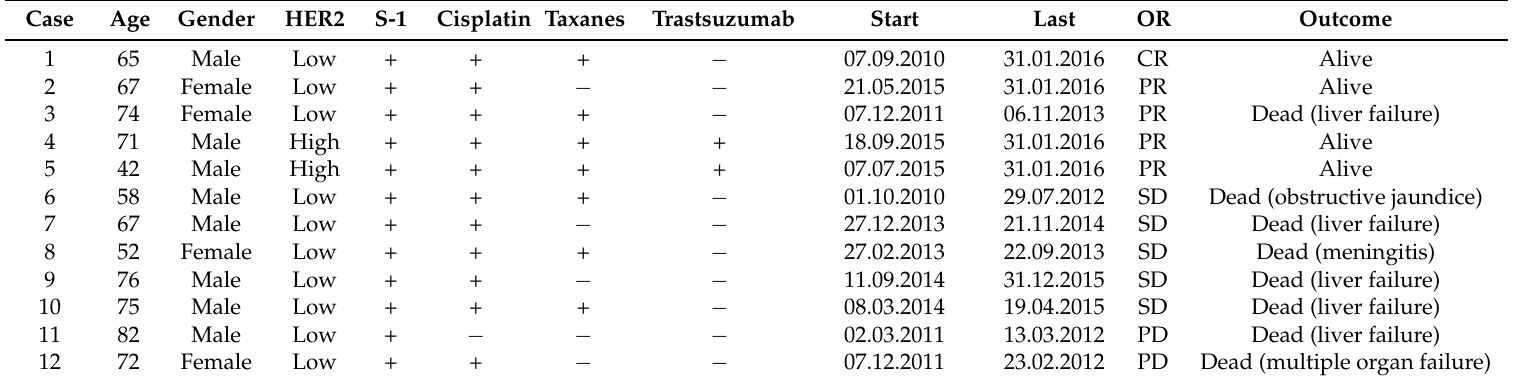
Table 2. Patients’ list.